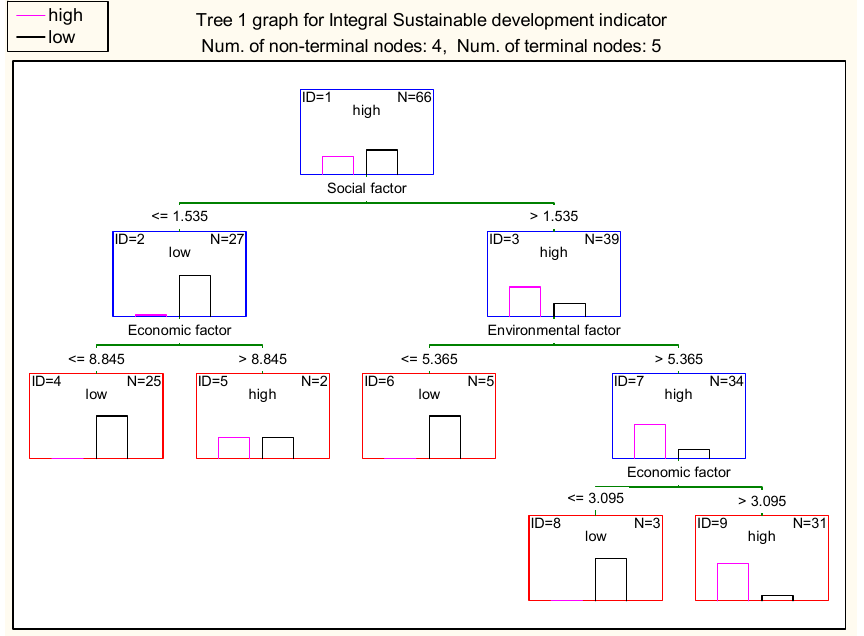
Figure 3. Classification tree for identifying patterns of innovative mesosystems sustainable development in industry (based on sustainable development factors).